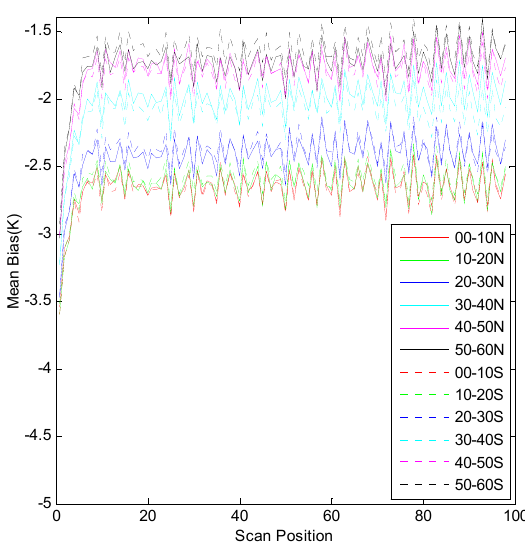
Figure 3. Scan bias by latitude band, FY-3C/MWHTS Channel 4.